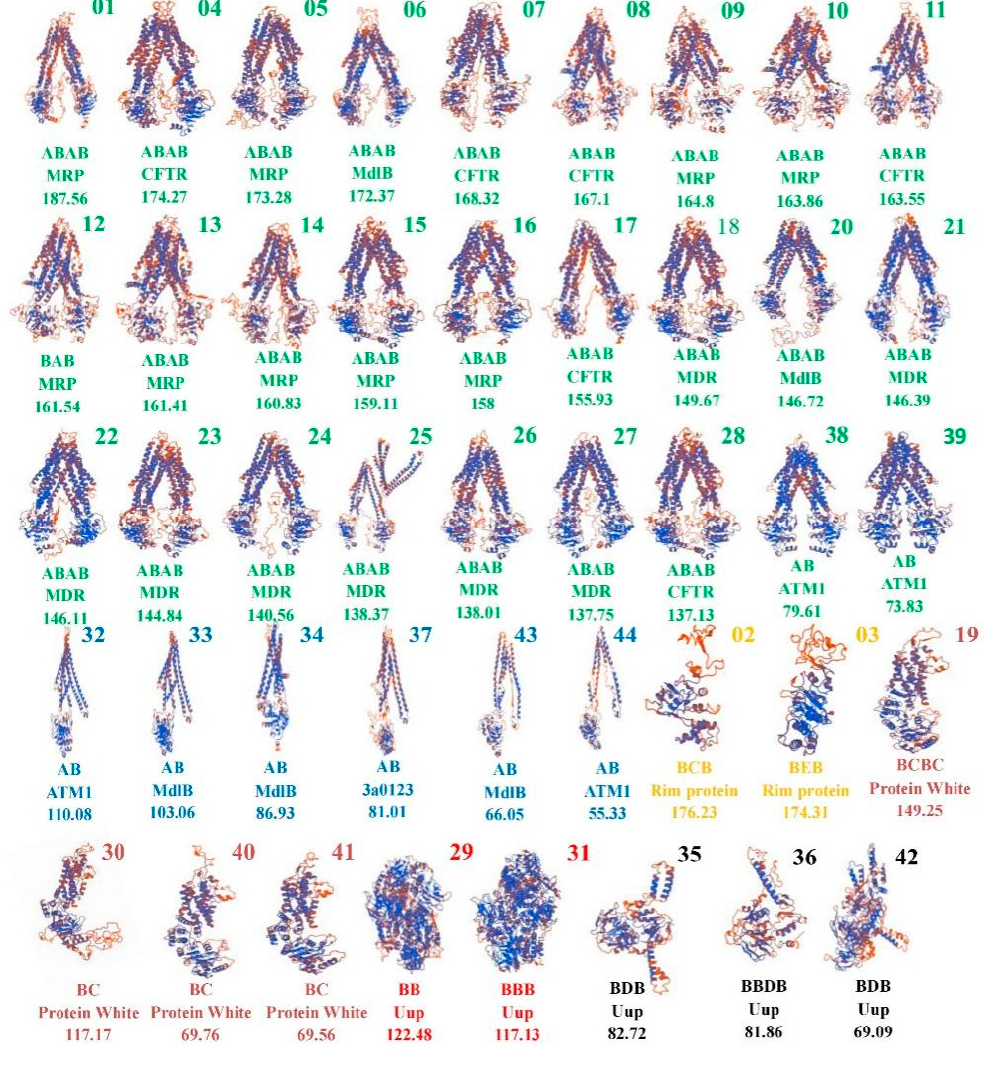
Figure 3. The predicted three-dimensional structures of the 44 ABC transporters in T. asperellum. The prediction was conducted using Clustal Omega (http://www.ebi.ac.uk/services/proteins, accessed on 13 March 2021). The number at the top right corner shows the protein number. The first line below the structure shows the order of conserved domains (A–E represents domains belonging to the ABC-membrane, ABC-ATPase, ABC2-membrane, ABC-tran-2, and acyl-transfer-3 superfamilies, respectively). The second line below the structure shows the multidomain type. The third line below the structure shows the protein molecular weight (kDa).